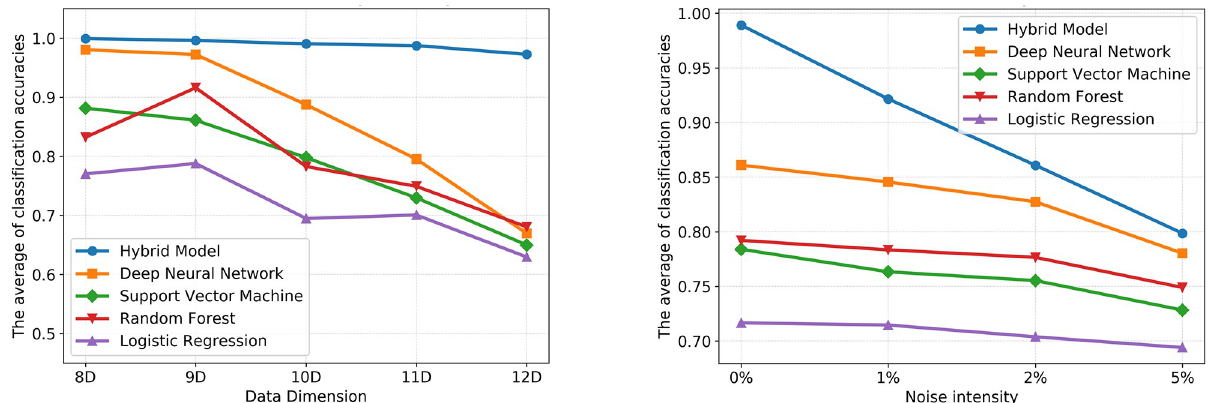
Fig 6. The influence of the dimensionality and the noise intensity of the synthetic data in the classification efficiency. The effect of data dimensionality (left) and noise intensity (right) in the average of the classification accuracy for 150 experiments executed for each model and for N = 200 data points.